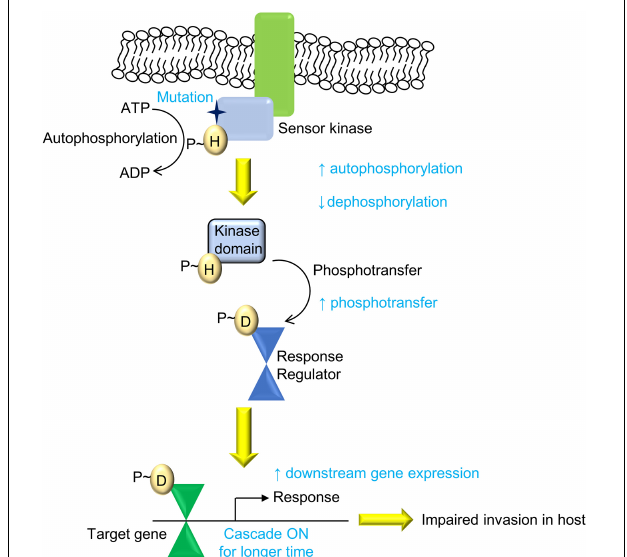
FIGURE 7 | Summary of the PhoPR two-component system (TCS) signaling cascade and the effect of the A400T mutation. The mutation (A400T) in the sensor kinase (SK) PhoR, which responds to low pH, enhances downstream gene expression because of higher autophosphorylation and reduced autophosphatase activity. This leads to enhanced phosphorylation of PhoP protein and its DNA-binding ability (shown in red). The signaling changes affect the invasion of the bacteria that harbor the mutation and reduce the prevalence of the strain carrying single-nucleotide polymorphism (SNP) in the